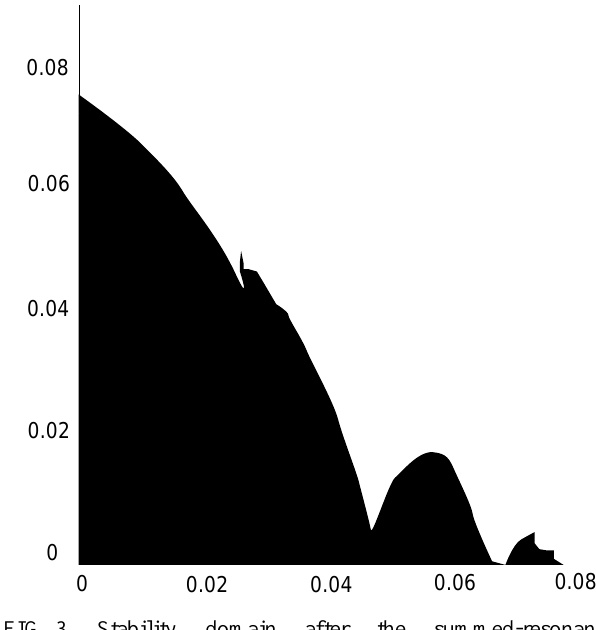
FIG. 3. Stability domain after the summed-resonance compensation.